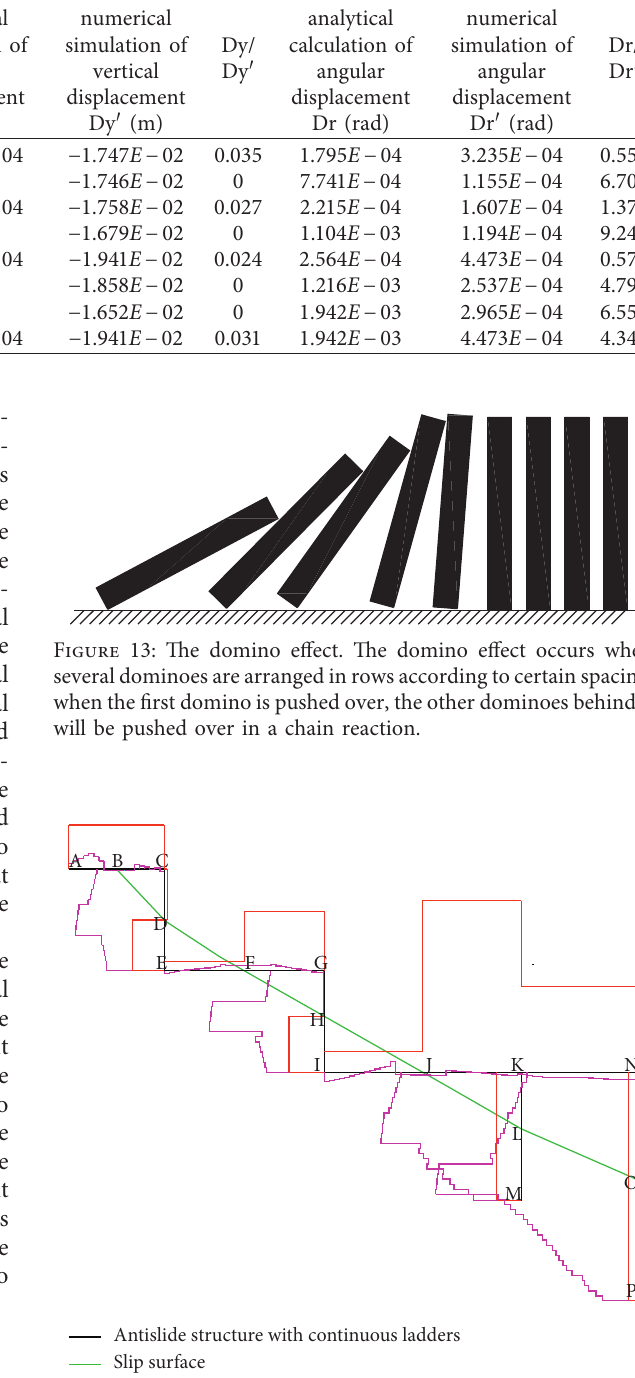
Figure 14: A comparison of the axial forces of the ASCL. The black lines represent the initial shape of the ASCL, and the green lines represent the slip surface. Taking the initial shape of the ASCL as a standard, the red lines represent the axial force of the analytical calculations, while the pink lines represent the axial force of the numerical